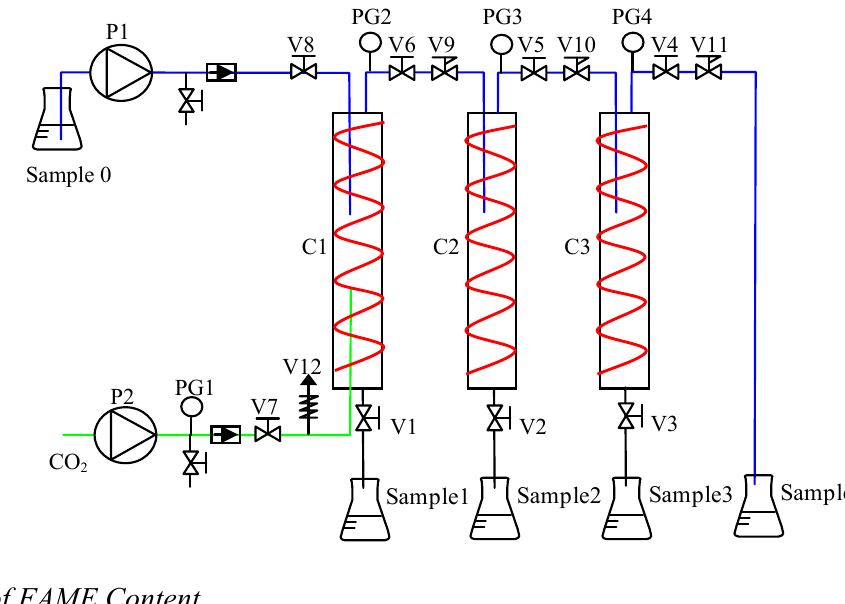
Figure 1. The schematic diagram of continuous super critical carbon dioxide